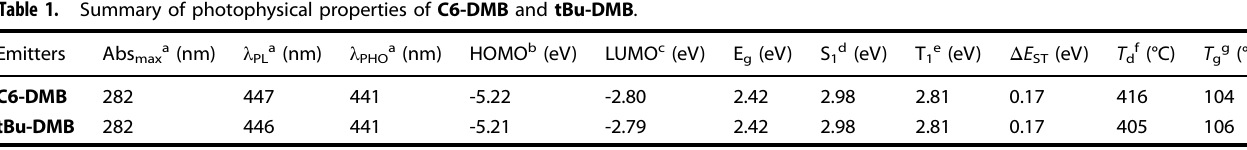
c Measured in oxygen-free DMF. d Estimated from the onset of fl uorescent spectra at 77 K. e Estimated from the fi rst peak of phosphorescent spectra at 77K. f Decomposition temperature corresponding to 5% weight loss from TGA measurement. g Glass transition temperature from DSC